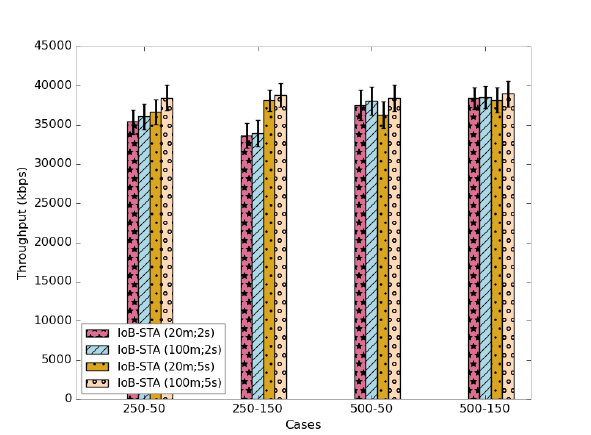
Figure 34. Average delivery rate for IoB-STA.